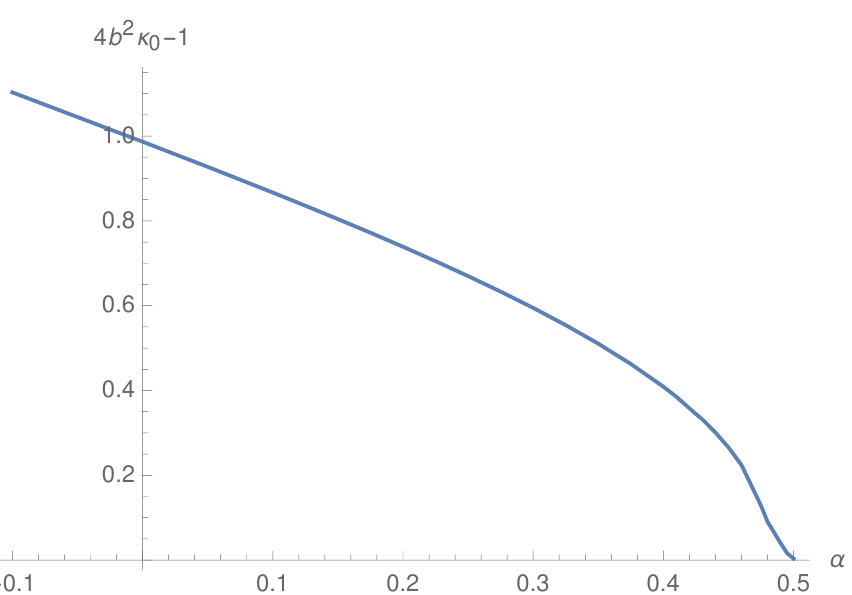
Figure 5. The value of the ‘cut-o(cid:11) variable’ 4 b 2 (cid:20) 0 (cid:0) 1 plotted as a function of (cid:11)